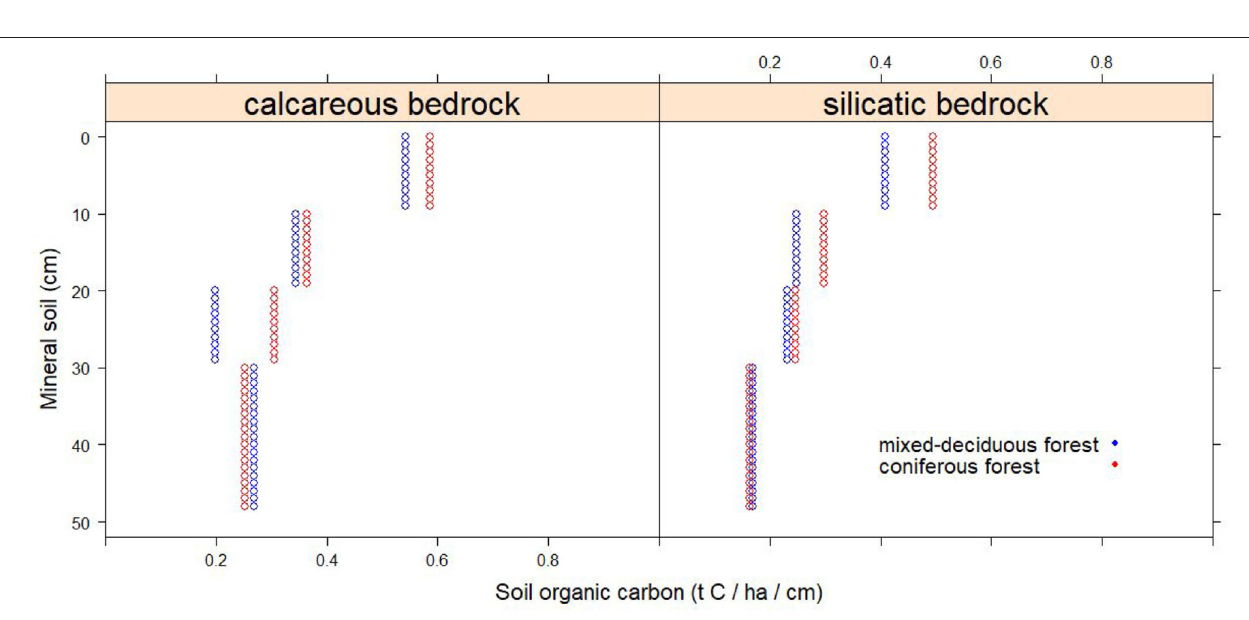
uncertainty of the belowground litterfall via root turnover that is pertinent in soil carbon models (Brunner et al., 2013).